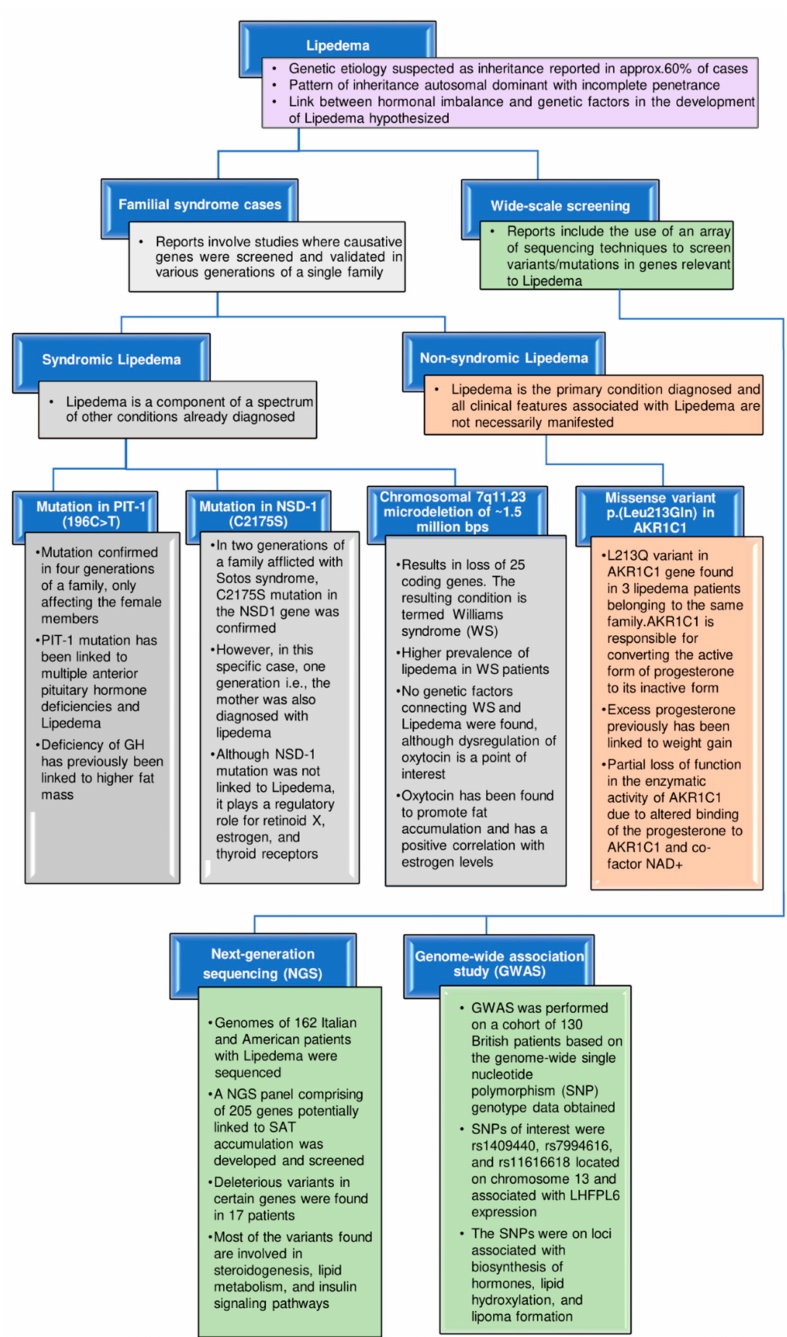
Figure 3. The flowchart depicts the holistic view of the current genetic implications for lipedema. Screening and validation of causative genetic factors performed in various generations of a single family are highlighted in familial syndrome cases of patients with lipedema. This is further catego- rized based on syndromic (described based on the chromosomal structural changes and a mutation in specific genes) and nonsyndromic (development of missense gene variants, i.e., L213Q variant in AKR1C1 gene) conditions. The wide-scale screening included next-generation sequencing (NGS) and genome-wide association studies (GWAS), revealing the variants/mutations in genes found to be linked or relevant to